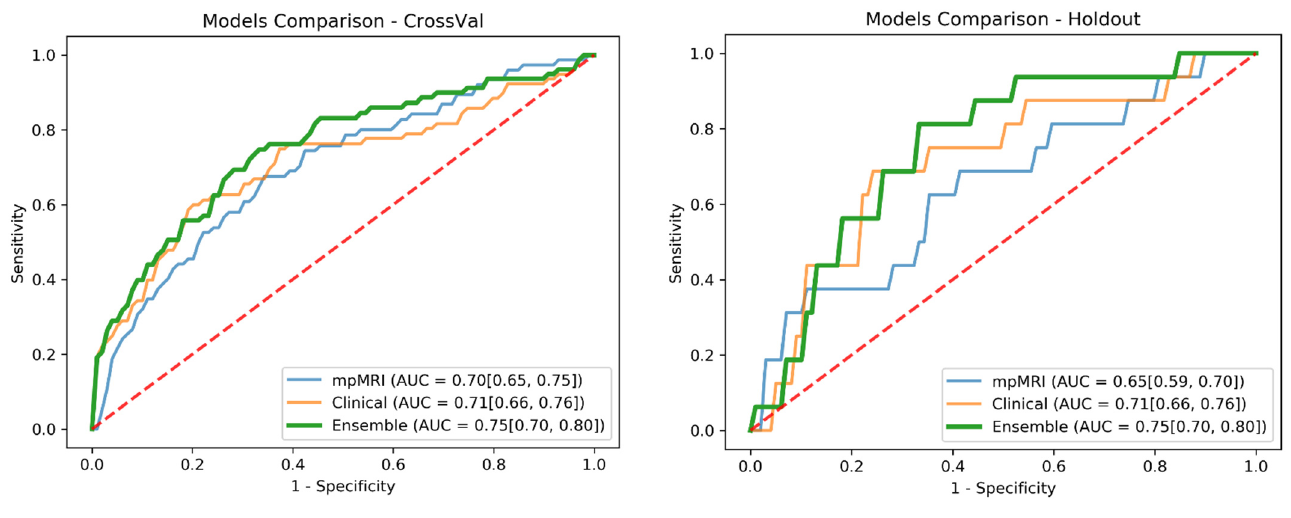
Figure 3. Cross-validation and holdout ROC curves for the mpMRI model, clinical model, and final ensemble model. ( a ) Cross-validation evaluation with ensemble model AUC of 0.75 (95% CI: 0.70, 0.80). ( b ) Holdout evaluation with ensemble model AUC of 0.75 (95% CI: 0.70,